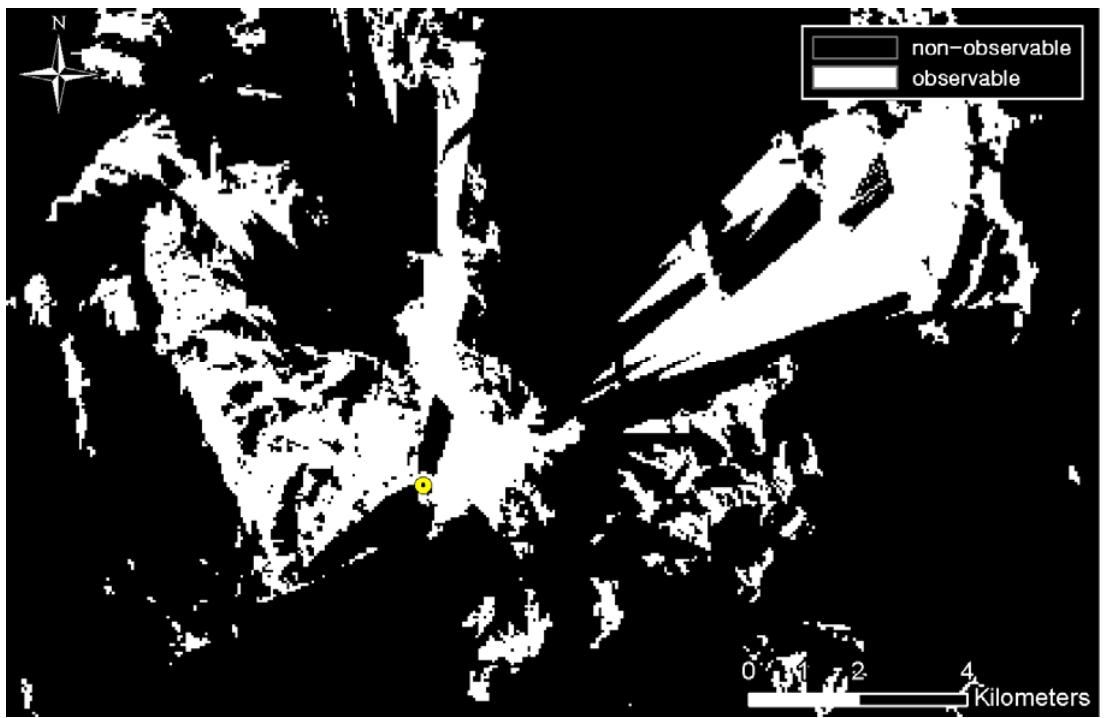
Figure 7. Viewshed analysis from individual TOD location.